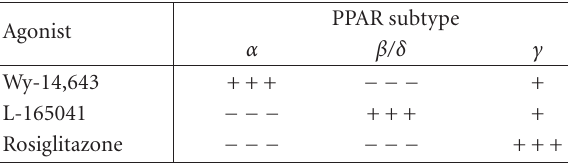
Table 1. Relative PPAR subtype-specificity of selected agonists.